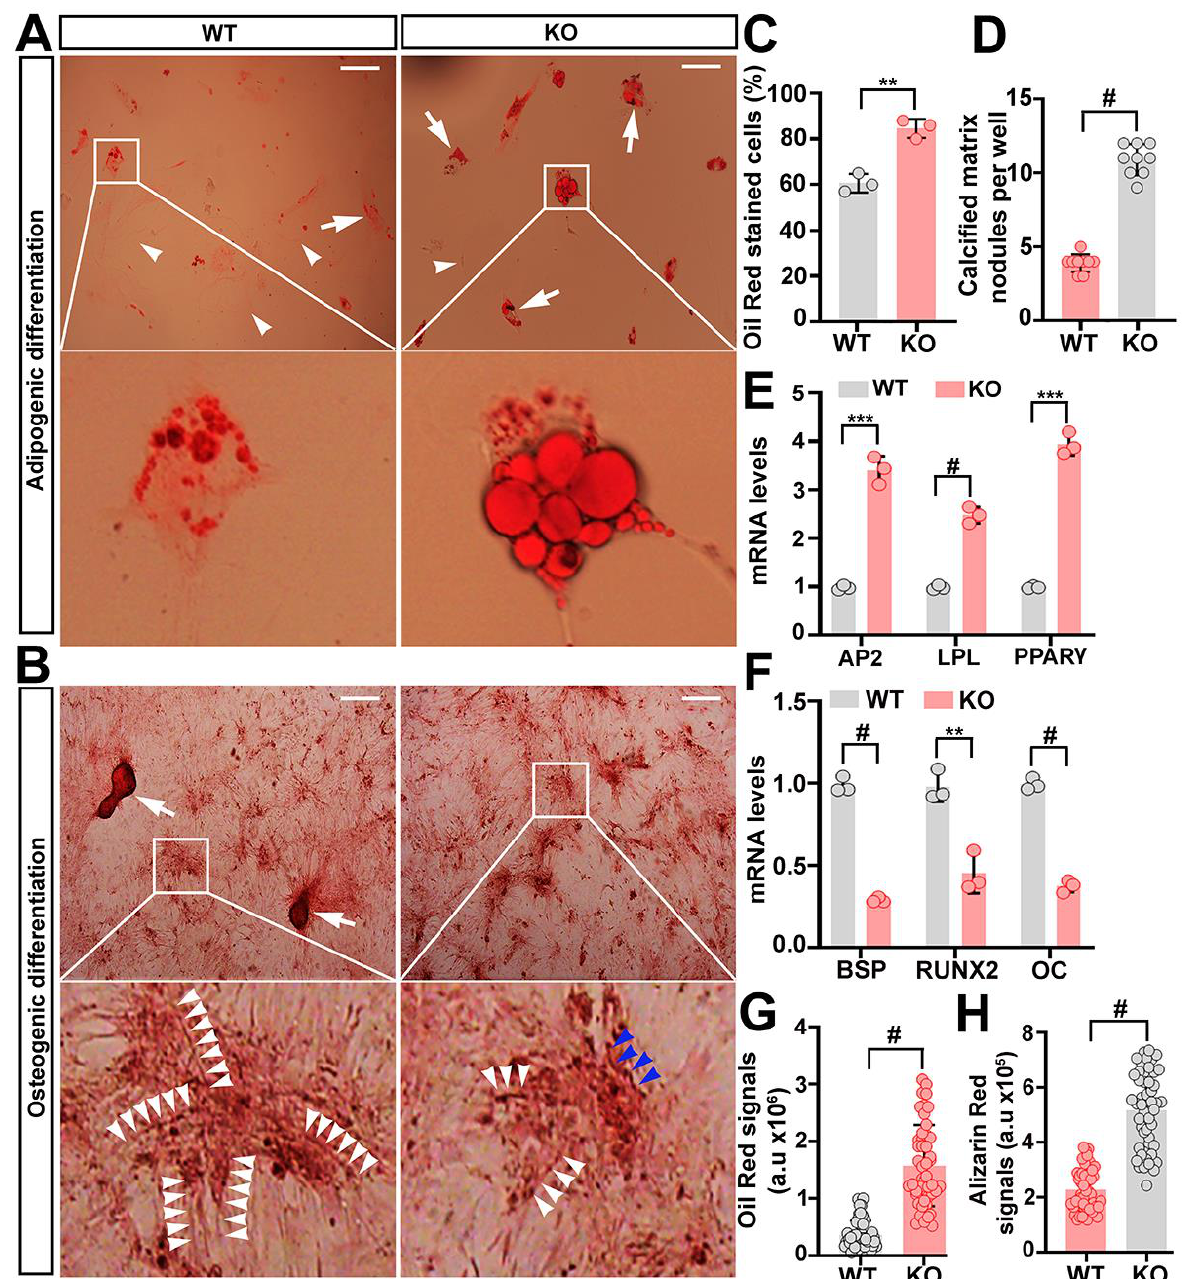
Figure 2. ( A – H ) Comparison of the lineage differentiation between WT and trappc9-deficient ASCs. After induced differentiation to the adipogenic ( A ) or osteogenic ( B ) lineage for 14 days, cells were stained with Oil red O ( A ) or Alizarin red ( B ) and imaged. Shown are examples of images of cells stained with Oil red O ( A ) or Alizarin red ( B ). Boxed regions were enlarged and shown beneath the corresponding image. Enlarged boxed regions in ( A ) highlighted clusters of aberrantly large lipid droplets in an adipogenic cell derived from trappc9-null (KO) ASCs. In images in ( A ), arrowheads point to cells that were stained with oil red, whereas arrows identified cells stained with oil red. Arrowheads in images of the enlarged boxed regions in ( B ) indicated the string pattern of mineral deposition in osteoblasts derived from WT ASCs; such string-like structures were twisted (blue ar- rowheads) in osteoblasts from trappc9-null (KO) ASCs. Scale bars: 100 μ m. Quantitative analysis of cells stained with Oil red or with Alizarin red ( C ) as well as qPCR analysis of transcripts for adipo- genic ( D ) and osteogenic ( E ) genes revealed that trappc9-deficient (KO) ASCs preferred adipogenic differentiation. In ( C ), average percentage of cells stained with oil red was graphed, whereas aver- age calcified matrix nodules per well was counted and used as a measure of osteogenic differentia- tion. ( F ) Densitometry quantification of signals for oil red ( A ) or Alizarin red ( B ) showed that upon